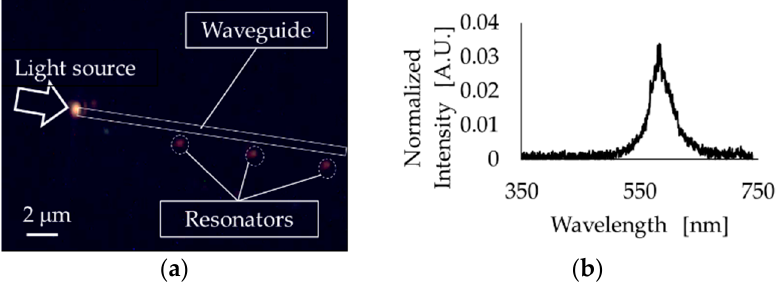
Figure 5. Microscopic observation of the PhC resonator and waveguide ( a ) and spectrum of the detected light at resonator ( b ).